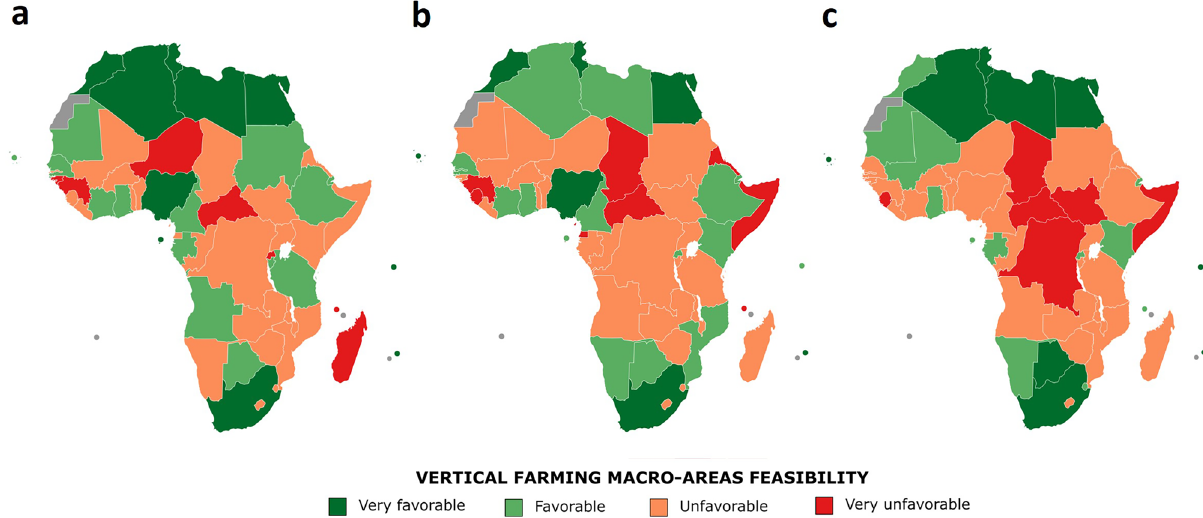
Figure 4. Categorization of vertical farming feasibility per macro-area in African countries. ( a ) Urban Agriculture Productivity Assurance and Food Security macro-area. Synthetic feasibility index (SFI) categorization as very favorable (> 0.519); favorable (0.519–0.419); unfavorable (0.419–0.318); very unfavorable (< 0.318). ( b ) Economic and Political Implications macro-area. Synthetic feasibility index (SFI) categorization as very favorable (> 0.380); favorable (0.380–0.290); unfavorable (0.290–0.200); very unfavorable (< 0.200). ( c ) Resources availability and Social Implication macro-area. Synthetic feasibility index (SFI) categorization as